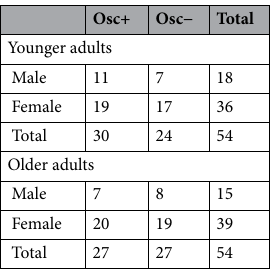
Table 1. Age group and sex for Osc+ vs.